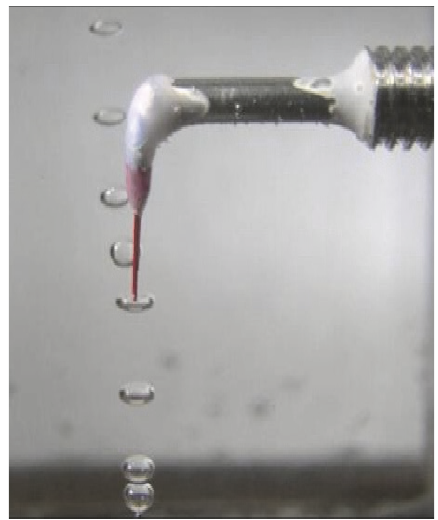
Figure 11: Interaction between the probe and the